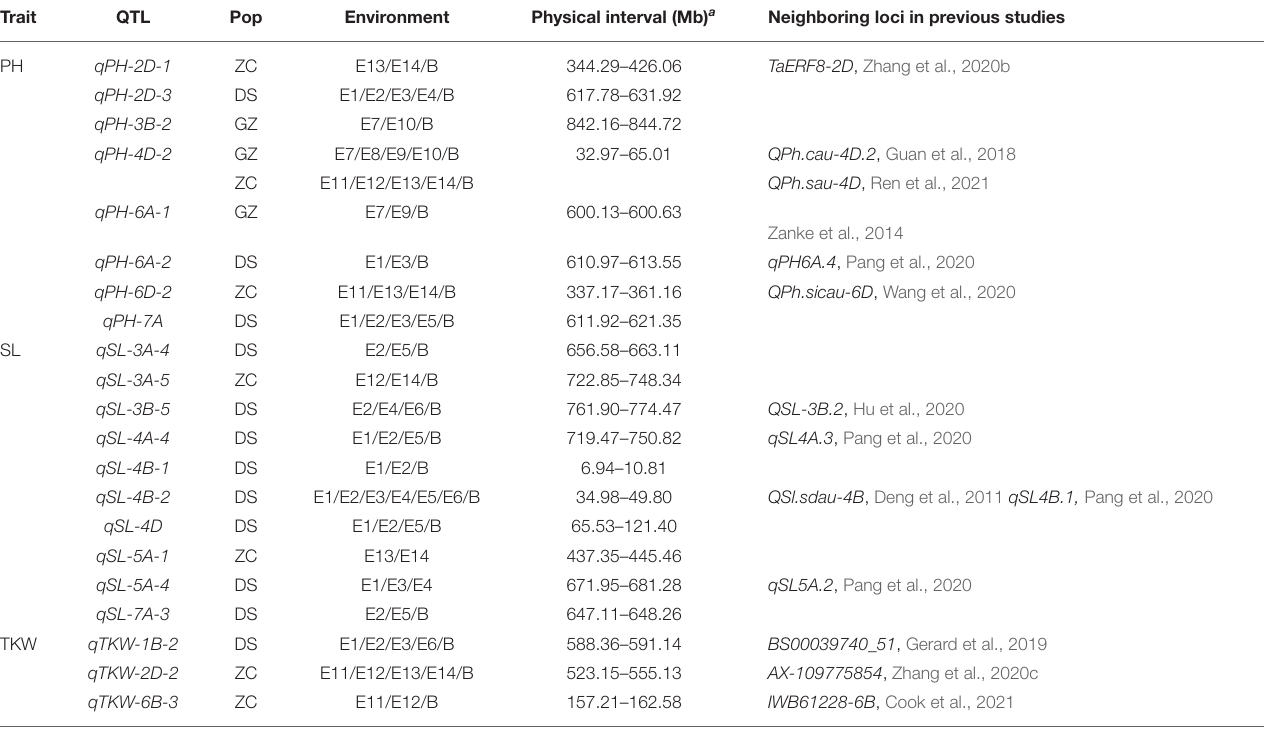
TABLE 7 | Quantitative trait loci for PH, SL, and TKW detected with the consensus map but not by the individual maps in the three RIL populations, DS, GZ, and ZC. Trait QTL Pop Environment Physical interval (Mb) a Neighboring loci in previous